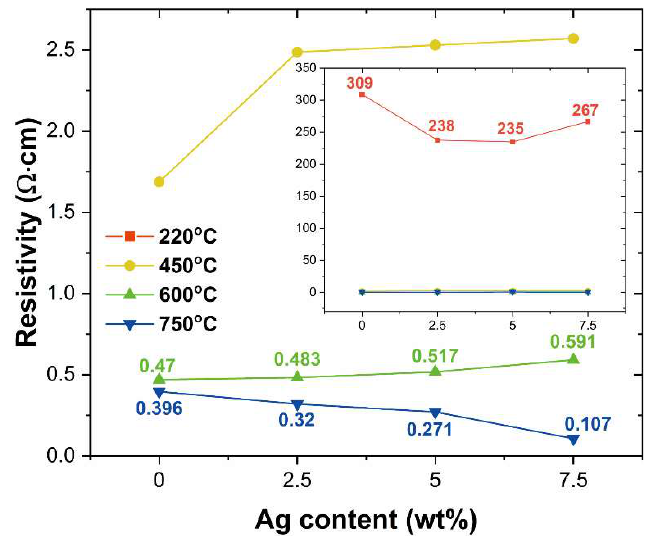
Figure 7. Magnified region of resistivity. Inset: overall resistivity of ITO and ITO@Ag thin films.